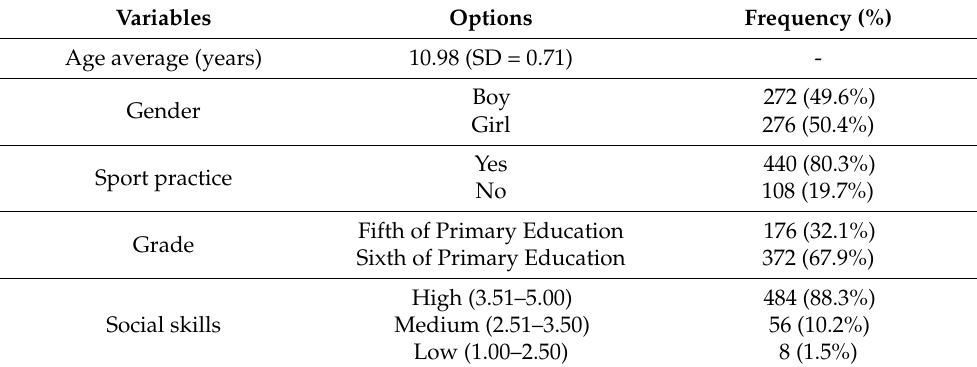
Table 1. Characterization of the